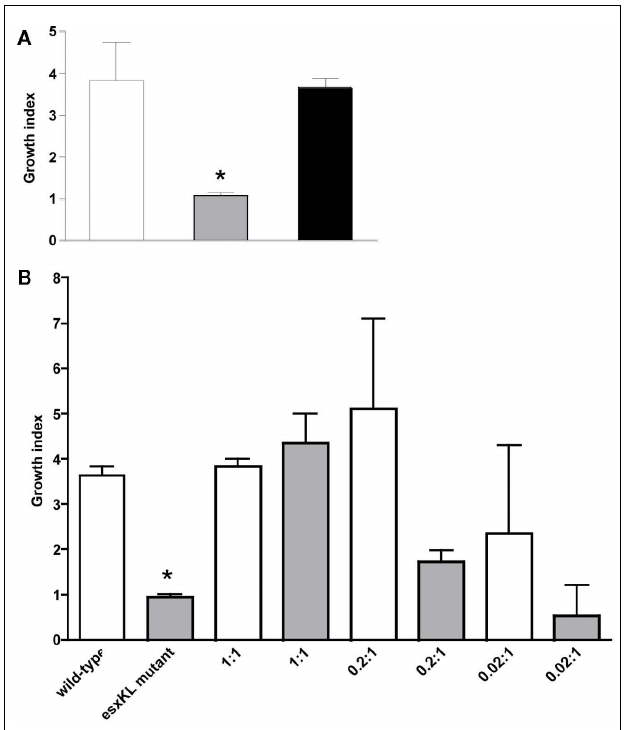
FIGURE 3 | Co-infection with wild-type allows intracellular growth of the Δ esxKL mutant population. (A) THP-1 monolayers were infected with wild-type or Δ esxKL mutant or 1:1 ratio of wild-type and Δ esxKL mutant strains at a MOI of 1:1. CFUs were determined at 24 and 96h post-infection. Growth indices are shown for wild-type (open bar), Δ esxKL (gray bar), and Δ esxKL sub-population in co-infection (black bar). Reduced intracellular growth of Δ esxKL mutant ( P < 0.005)* was rescued by co-infection with wild-type bacteria. A representative of three independent experiments is shown (B) THP-1 monolayers were co-infected with fixed number of Δ esxKL and varying concentration of wild-type H37Rv. Growth index at 96h post-infection for wild-type (open bar) and Δ esxKL (gray bar) in each co-infection well was determined. Data from a single experiment is shown.